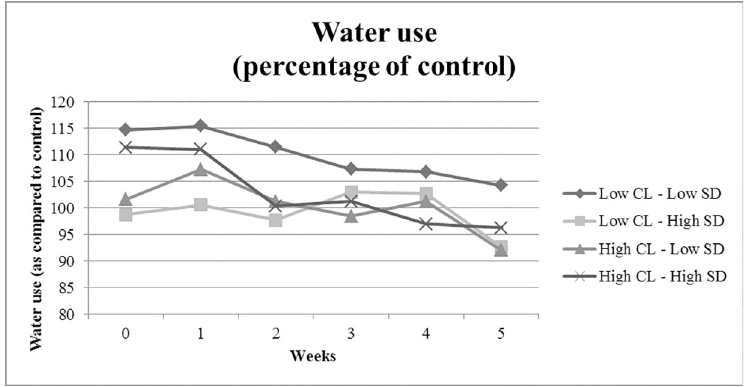
Fig 2. Water use depicted as percentage of control group during the six-week intervention period. CL = construal level, SD = social distance.